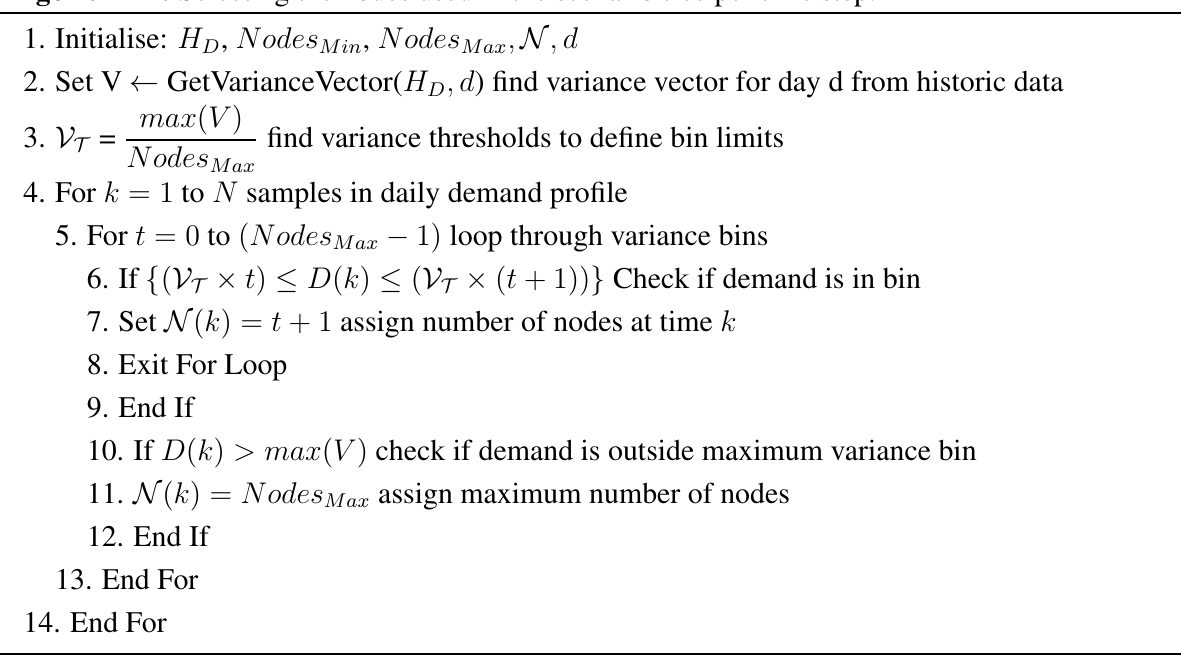
Algorithm 1: Selecting the nodes used in the scenario tree per time